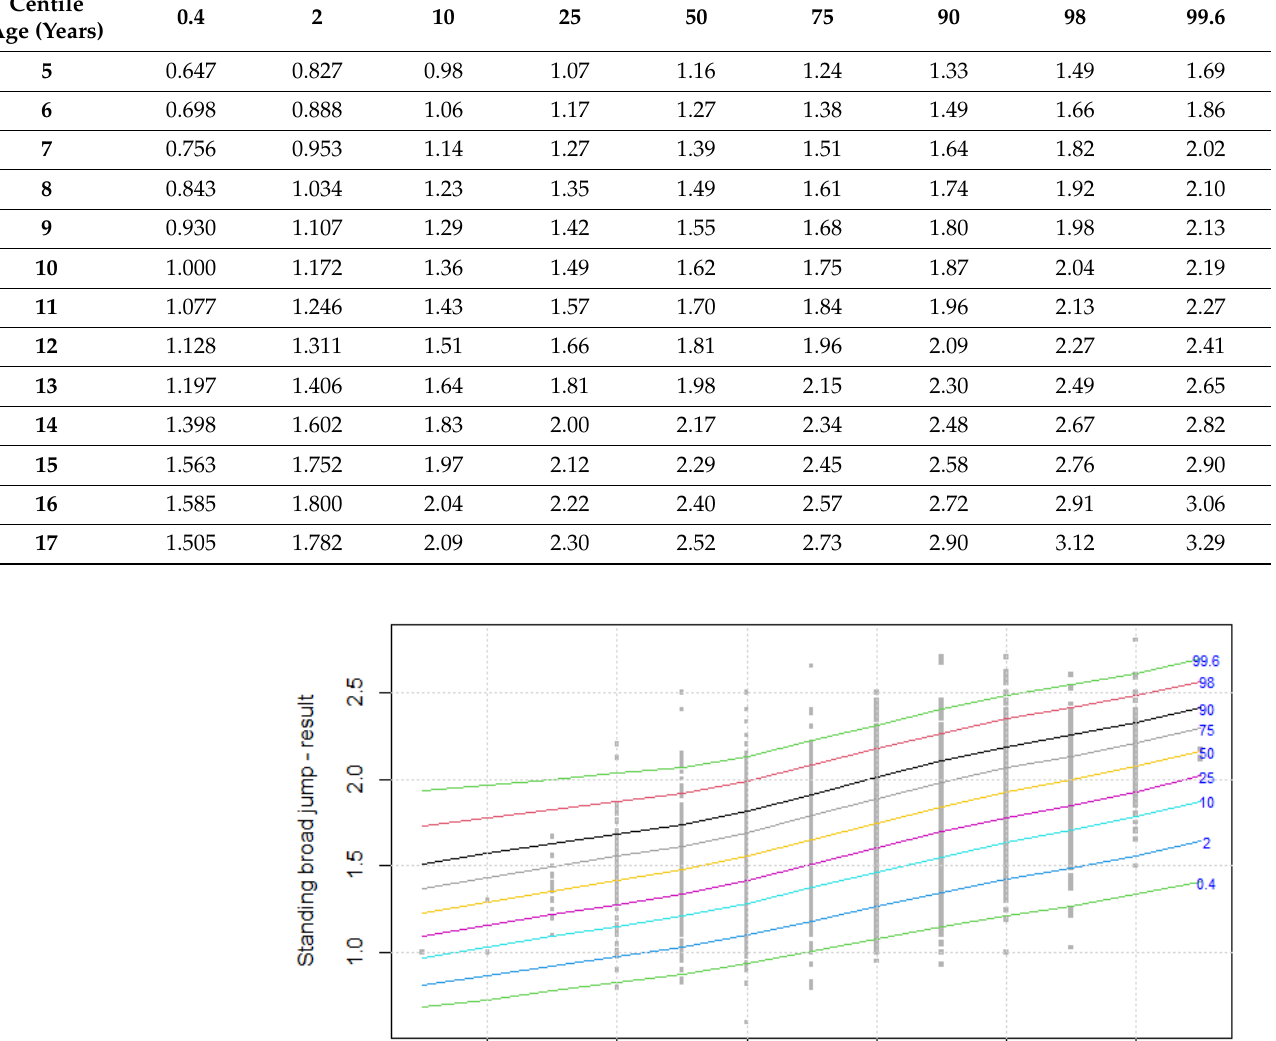
Table 6. Values of particular centiles for standing broad jump in boys.